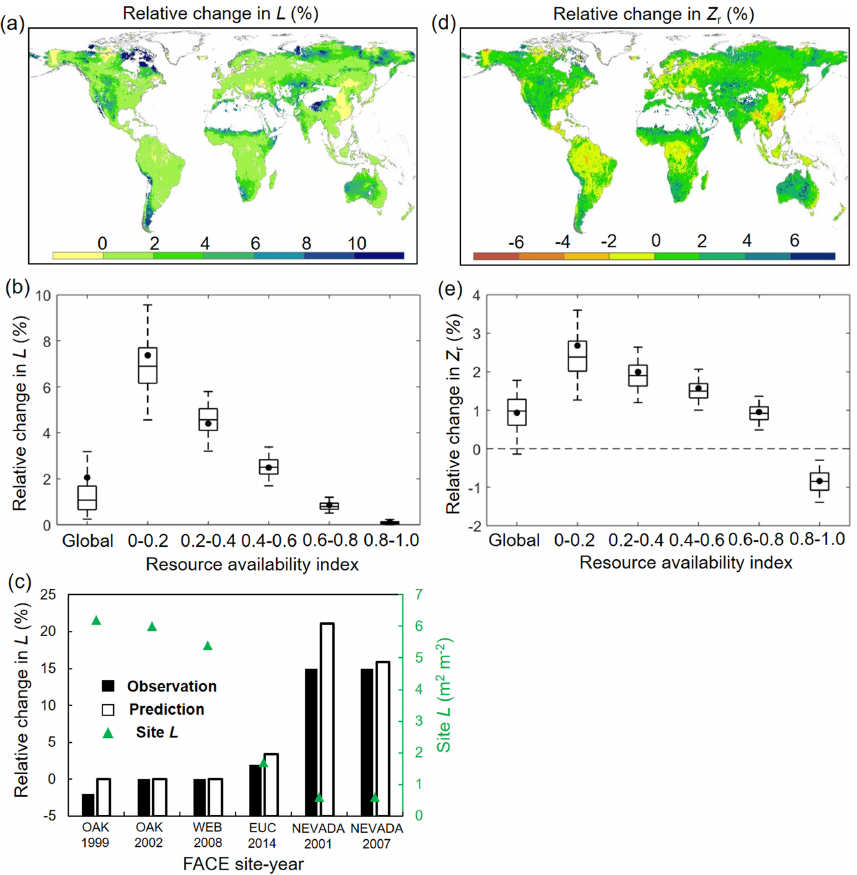
Figure 5. Modeled relative changes in L and Z r caused by eCO 2 . (a) Spatial distribution of relative change in L induced by eCO 2 during 1982–2010. (b) Same as (a) but for each resource availability index category. (c) Validation of predicted L change against in situ measurement during six Free-Air CO 2 Enrichment (FACE) experiments. Note that only FACE sites with undisturbed vegetation are used (see Donohue et al., 2017). (d) Spatial distribution of relative change in Z r induced by eCO 2 during 1982–2010. (e) Same as (d) but for each resource availability index category. In panels (b) and (e) the upper and lower box edges represent the quartile divisions, the inner horizontal line is the median, the dots indicate the mean, and the dashed lines represent the 5th and 95th percentiles. The number of grid cells in each resource availability index category is provided in Fig.